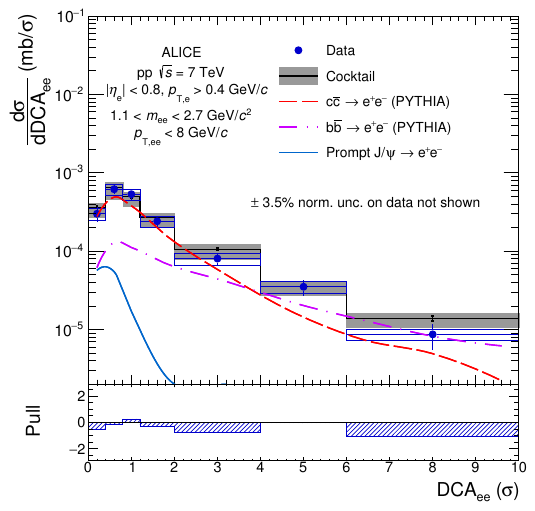
p s = 7 TeV in the